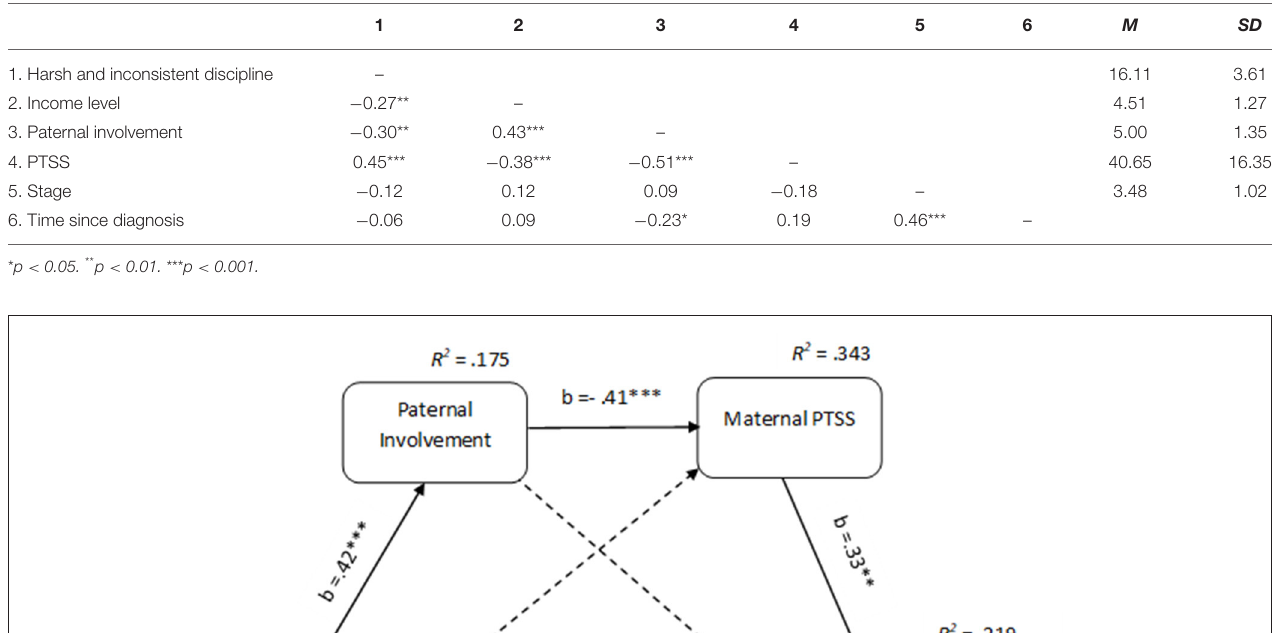
TABLE 1 | Means, standard deviations, and zero-order correlations of the study variables.